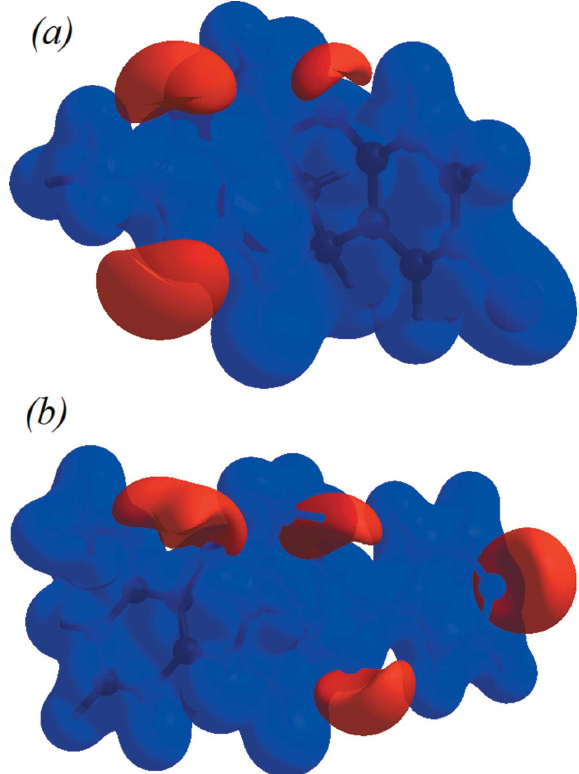
Figure 9 The view of the three-dimensional Hirshfeld surface of ( a ) compound I and ( b ) compound II , plotted over the electrostatic potential surface.